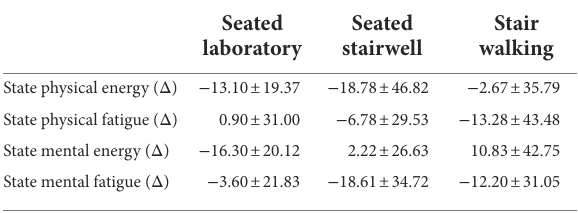
TABLE 4 State energy and fatigue change scores (M ± SD) by group.